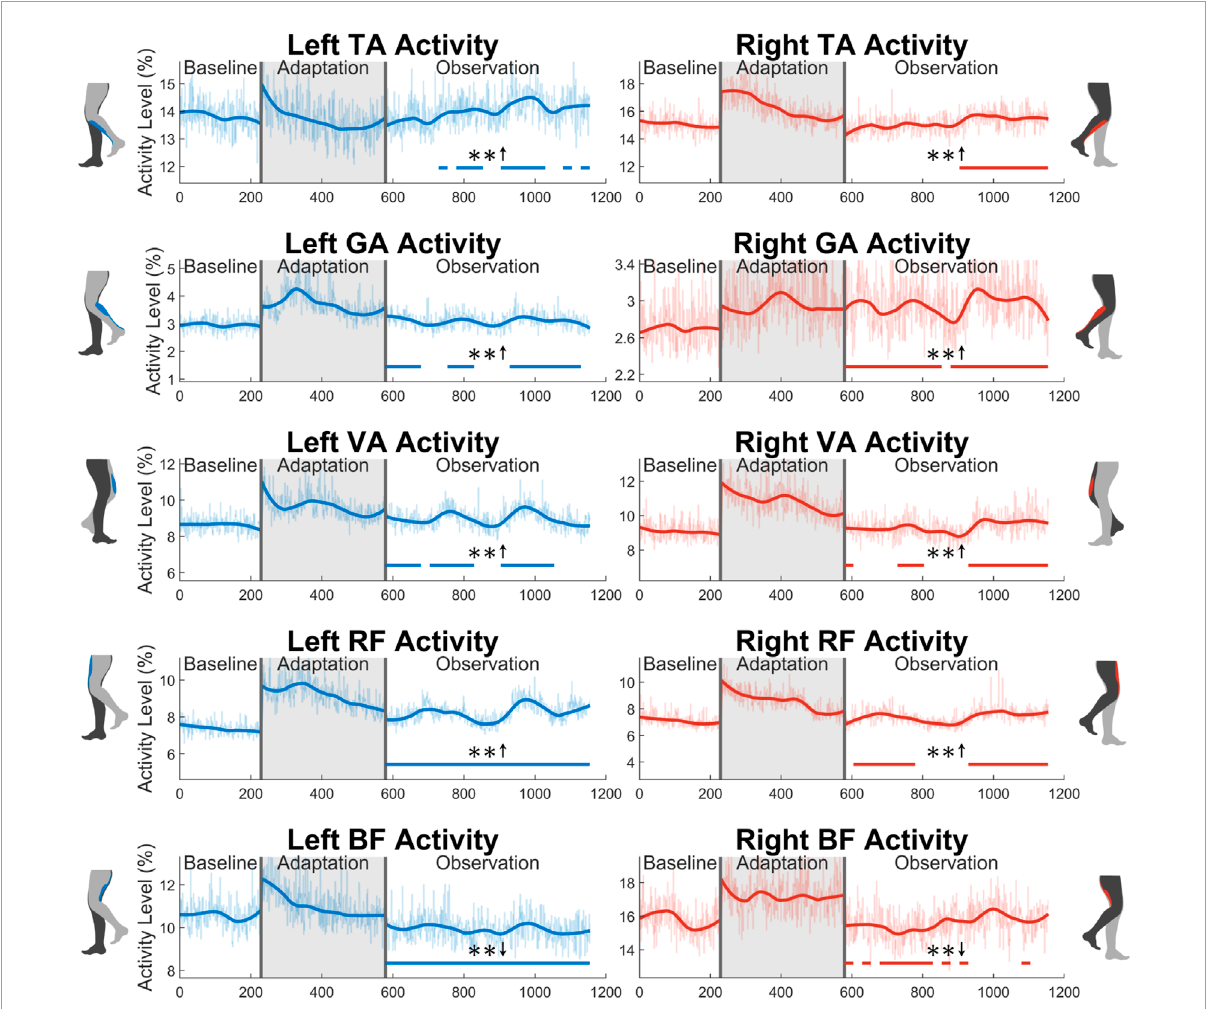
FIGURE 11 Average muscle activity during swing phase for all 10 muscles measured in this study: tibialis anterior, gastrocnemius, vastus medialis, rectus femoris, and biceps femoris. Significance is shown in the observation phase as compared to the baseline phase by the significance line. All significance testing was performed on “unsmoothed” data (seen in the lighter line). The darker line is the data smoothed by 2nd-degree polynomial local regression and was added only to allow the reader to more clearly see trends in the